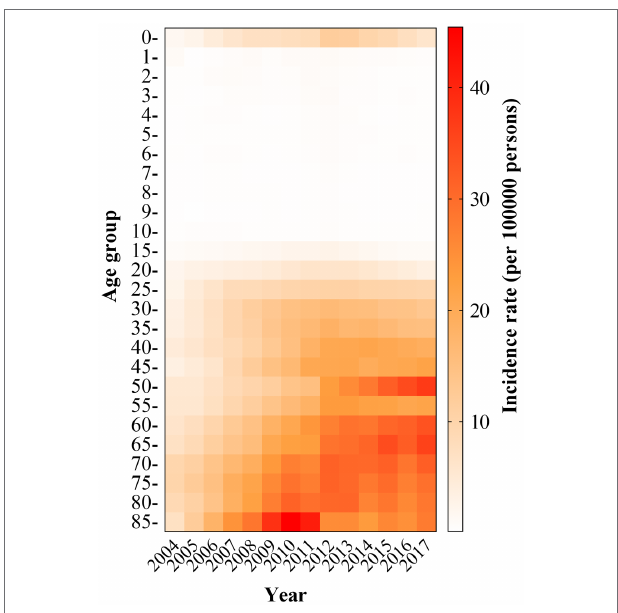
FIGURE 3 | Incidence of reported HCV infection in different age groups in China, 2004–2017. The reported incidence rate by different age groups was obtained from a website